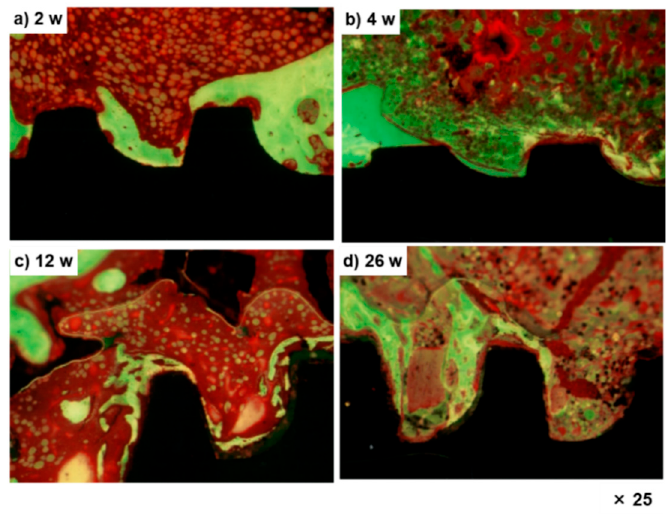
Figure 5. Optical micrographs of new bone formed around Ti–15–4–4 dental implant after 2 ( a ), 4 ( b ), 12 ( c ), and 26 ( d ) weeks.